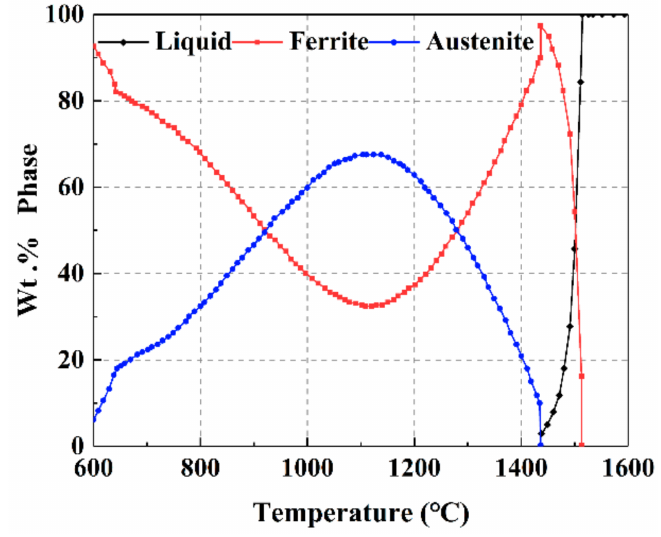
Figure 3. Equilibrium phase diagram of experimental